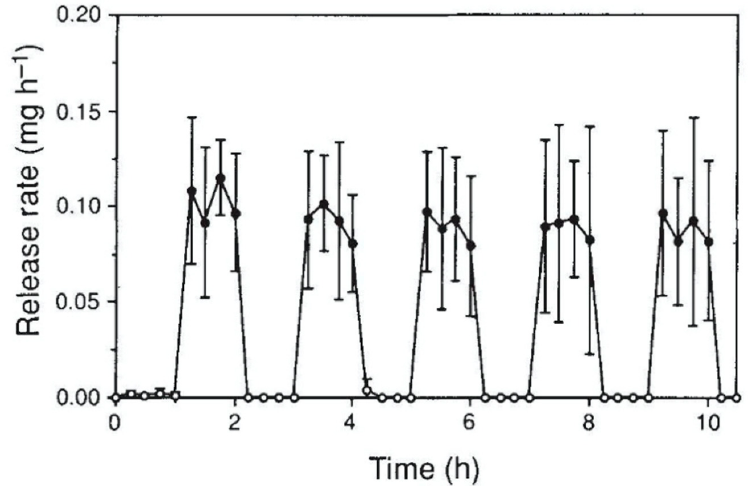
Figure 5. Insulin release rate of insulin-loaded hydrogels as a function of electric current [33]. Reproduced from [33] with permission. Copyright (1991) Springer Nature.